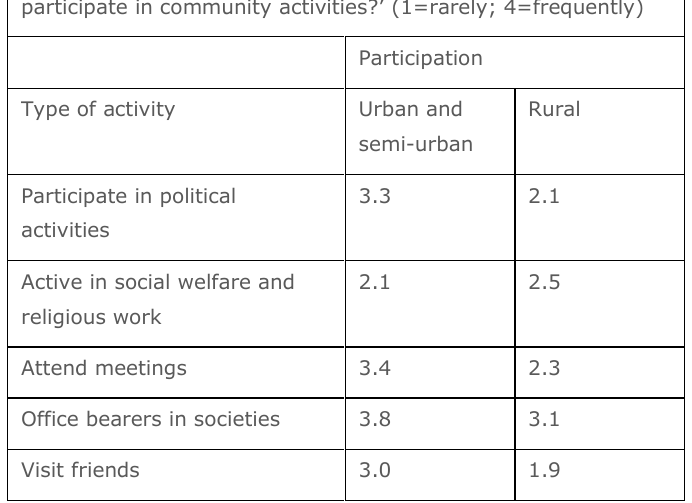
Table 5: Average agreement with the statement ‘do